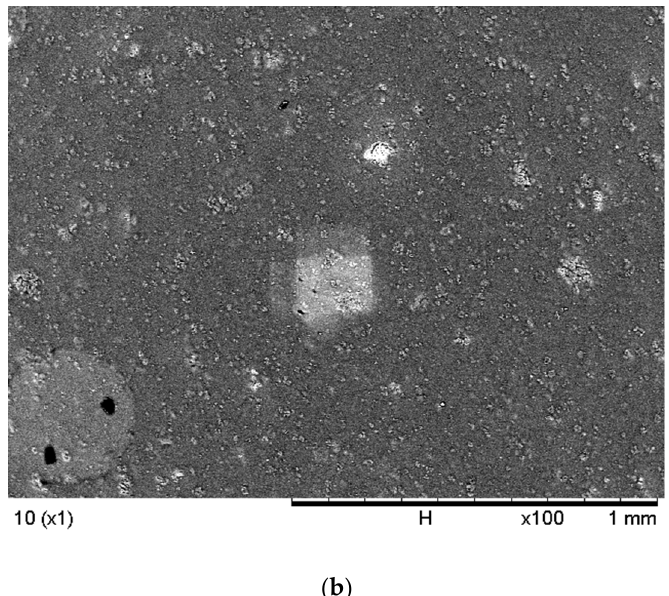
Figure 2. The SEM images of the ( a ) PIM (without nanoparticles) and ( b ) MM-PIM (with nanoparticles).